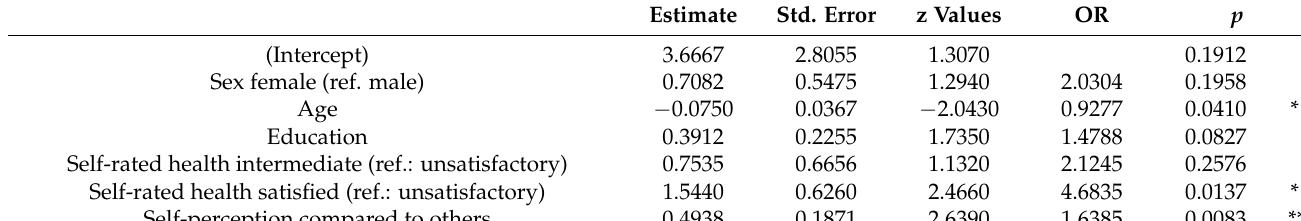
Table 2. General linear model of being able to execute activities of daily living regressing on sex, age, education, self-rated health, and self-perception compared to others on basis of a binomial error structure; * p < 0.05, ** p < 0.01.